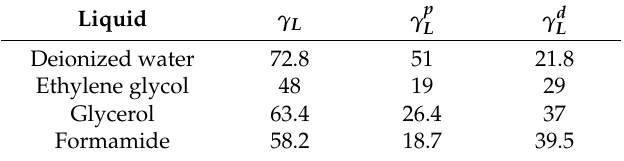
Table 1. Parameters of the reference liquids for determining asphalt surface energy (MJ/m 2 ). Liquid γ